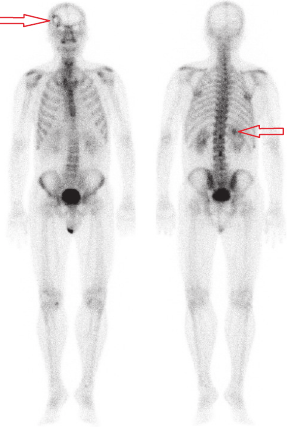
Figure 4: Bone scan showing right calvarial metastatic deposit and indistinct photopaenia at interpolar region of right kidney corresponding to primary